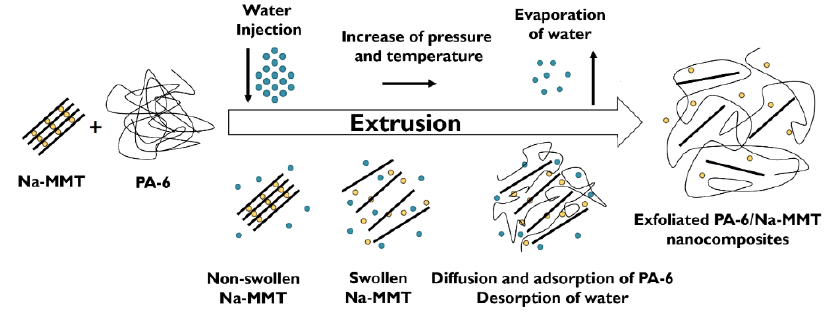
Figure 2. Montmorillonite (MMT) exfoliation in PA-6 during WA melt